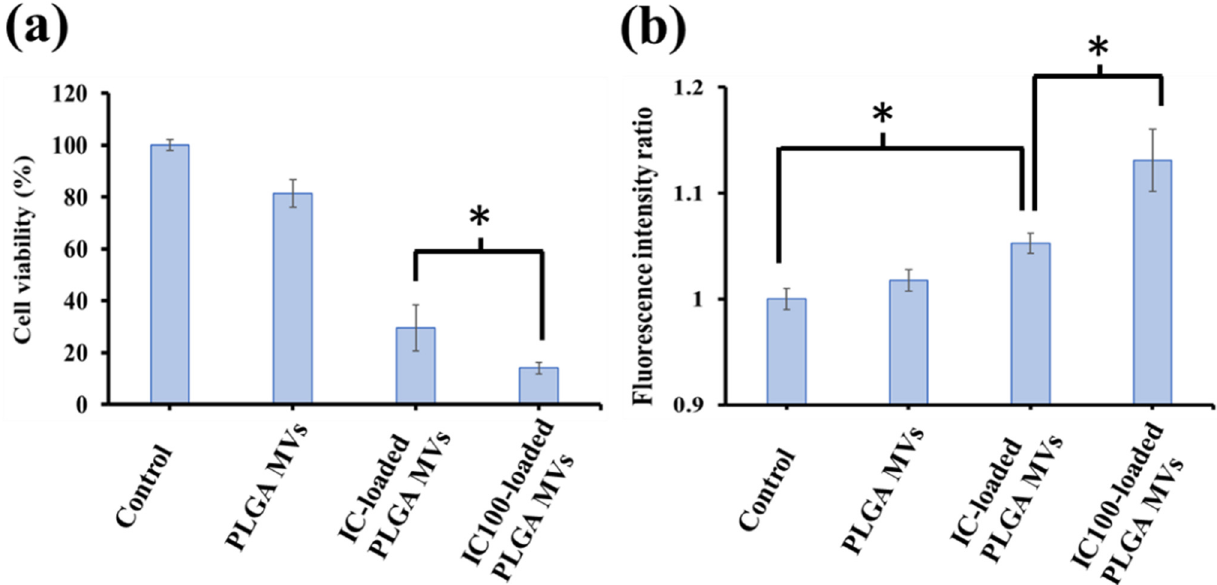
Figure 7. The in vitro study was used to evaluate the cytotoxicity of CO therapy. ( a ) The cell viability analysis of A549 cancer cells treated with medium alone (control), PLGA MVs, IC ‐ loaded PLGA MVs, and IC100 ‐ loaded PLGA MVs. * p < 0.05, calculated and compared to IC ‐ loaded and IC100 ‐ loaded PLGA MVs. ( b ) The intracellular ROS levels of A549 cancer cells treated with medium alone (control), PLGA MVs, IC ‐ loaded PLGA MVs, and IC100 ‐ loaded PLGA MVs were determined by the fluorescence intensity of APF dye at 525 nm. * p < 0.05, calculated and compared to IC ‐ loaded and IC100 ‐ loaded PLGA MVs as well as control and IC ‐ loaded PLGA MVs.